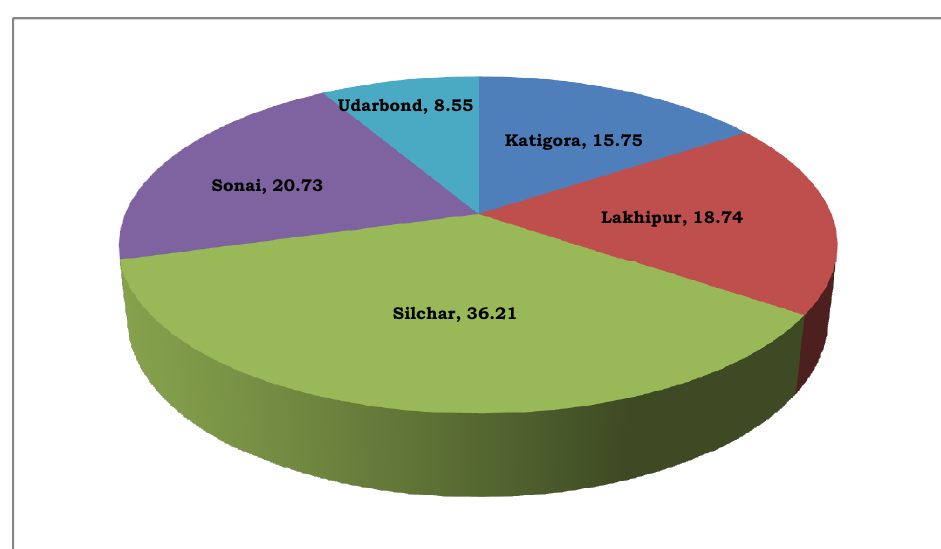
Figure 8. Percentage of minor roads in Cachar